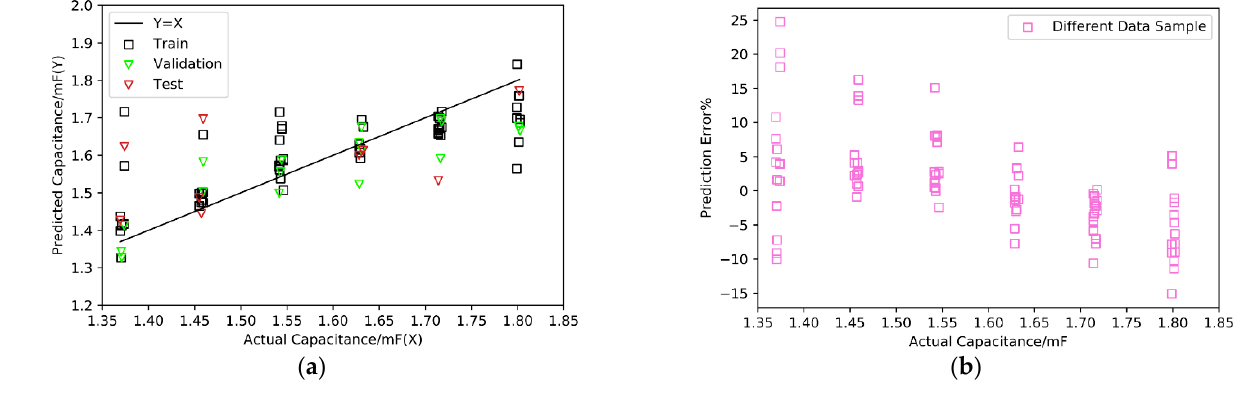
Figure 14. C Estimation results under experiments by SVR ( a ) a best fitting showing train, test and validation results; ( b ) cross validation showing PEs for 10 fittings under 10 random data divisions.